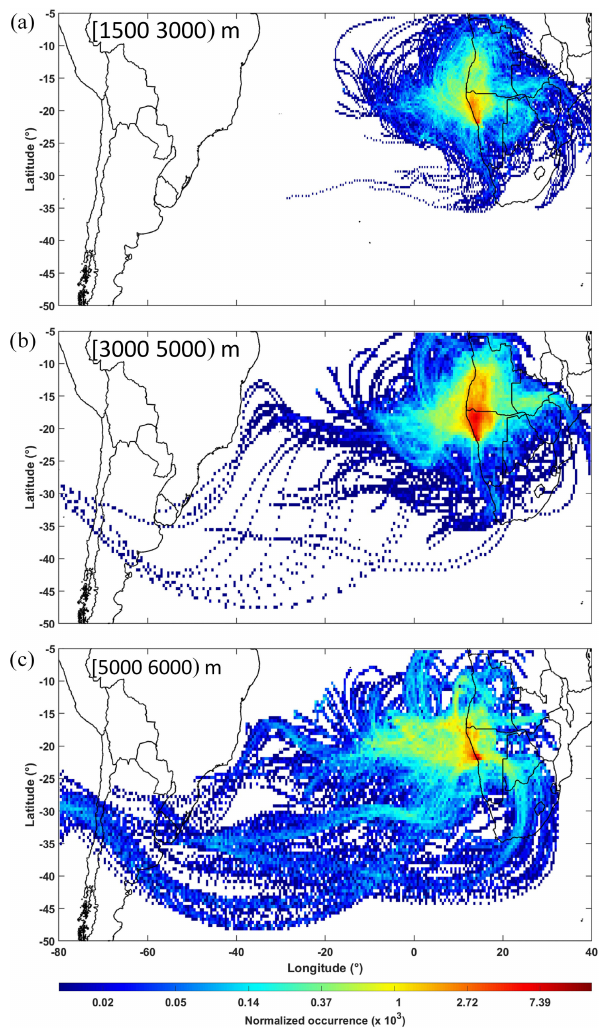
Figure 15. Normalized occurrence of the back trajectories start- ing over Henties Bay at 12:00UTC during period P 3 from the altitude ranges of [1500 3000[ (a) [3000 5000[ (b) and [5000 6000[m (c) . The calculations have been made using 6d isentropic back trajectories with the HYSPLIT model (courtesy of NOAA Air Resources Laboratory; http://www.arl.noaa.gov, last access: 23 November 2019) in ensemble mode. The normalization is per- formed with respect to the total number of pixels for a horizontal resolution of 0.5 ◦ .